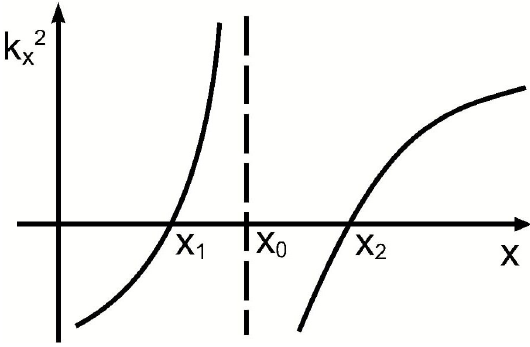
Fig. 1. The wave vector radial component squared, k 2 x .